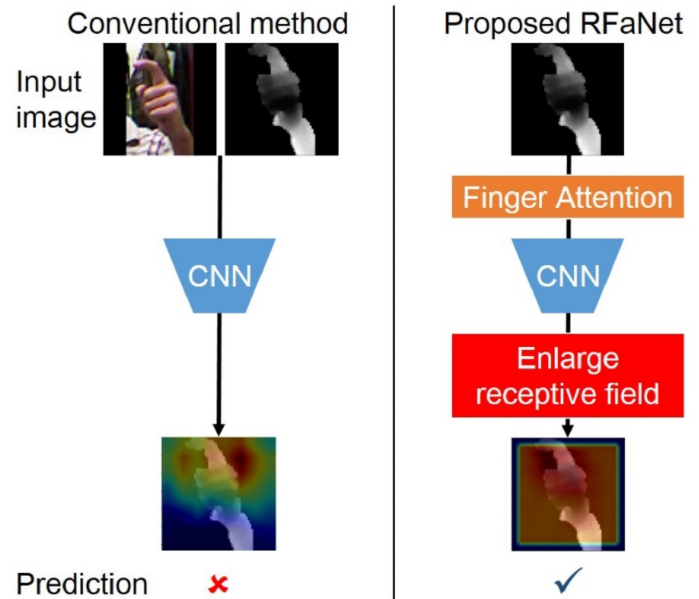
Figure 2. Hand gesture recognition models: ( left ) the conventional method and ( right ) RFaNet. Most conventional methods recognize hand gestures in color and depth input images, whereas RFaNet only processes a depth image to recognize hand gestures. RFaNet employs finger attention to highlight fingers before a CNN extracts the features and enlarges the RF to build long-range connections across finger features for better hand-gesture